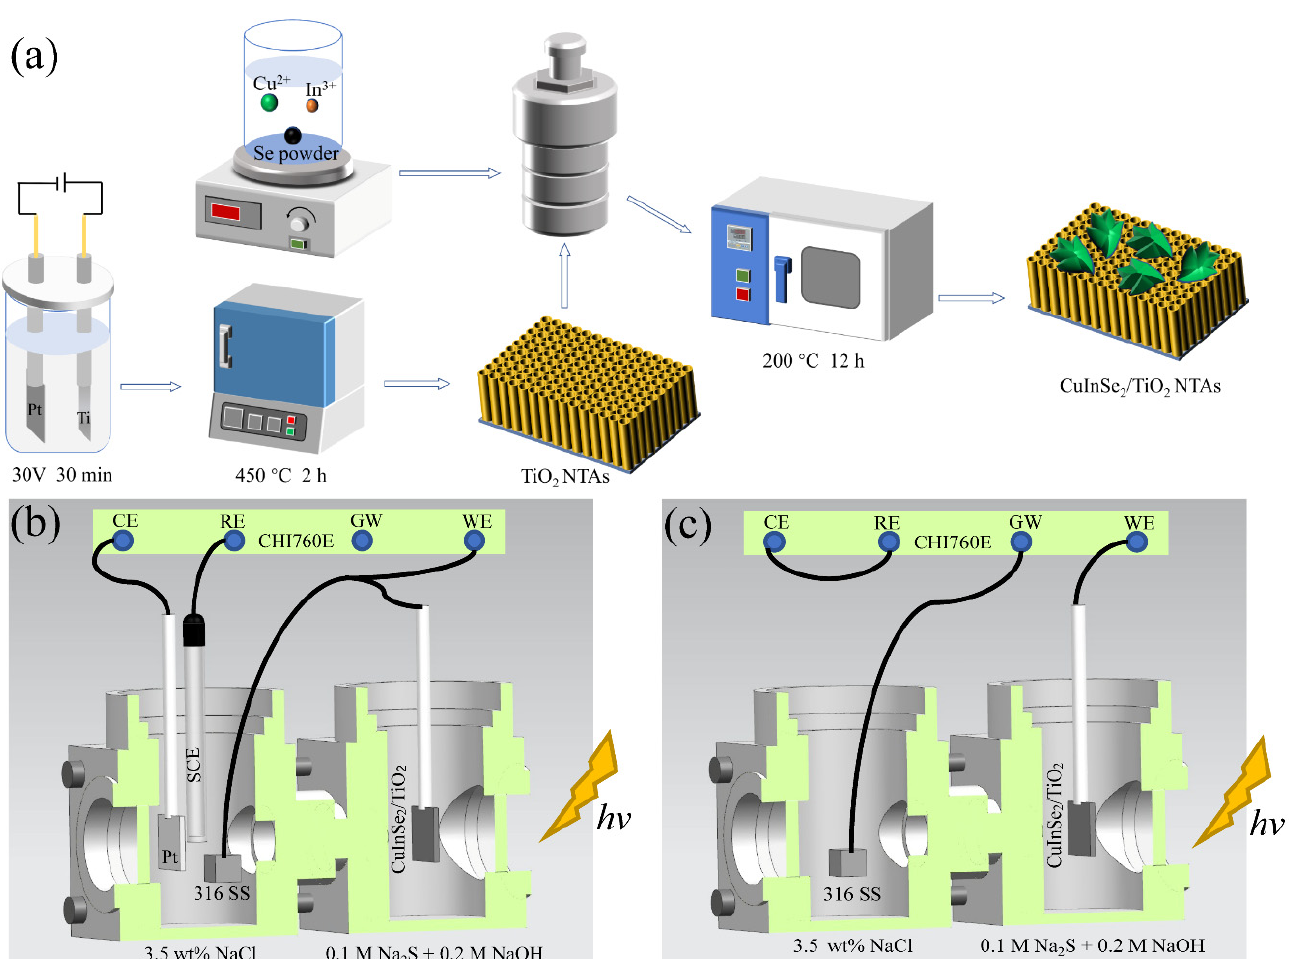
Figure 1. Schematic illustration of ( a ) the synthesis process for the CuInSe 2 /TiO 2 NTAs. Test devices for measuring ( b ) OCP, Tafel and EIS, and ( c ) photocurrent densities.